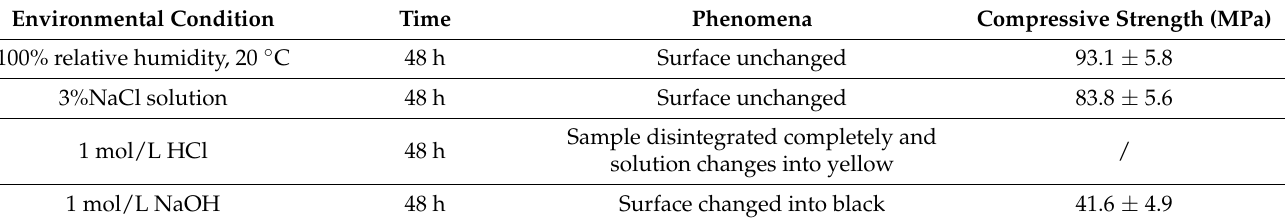
Table 4. Corrosion resistance test results of the geopolymers [37]. Environmental Condition Time